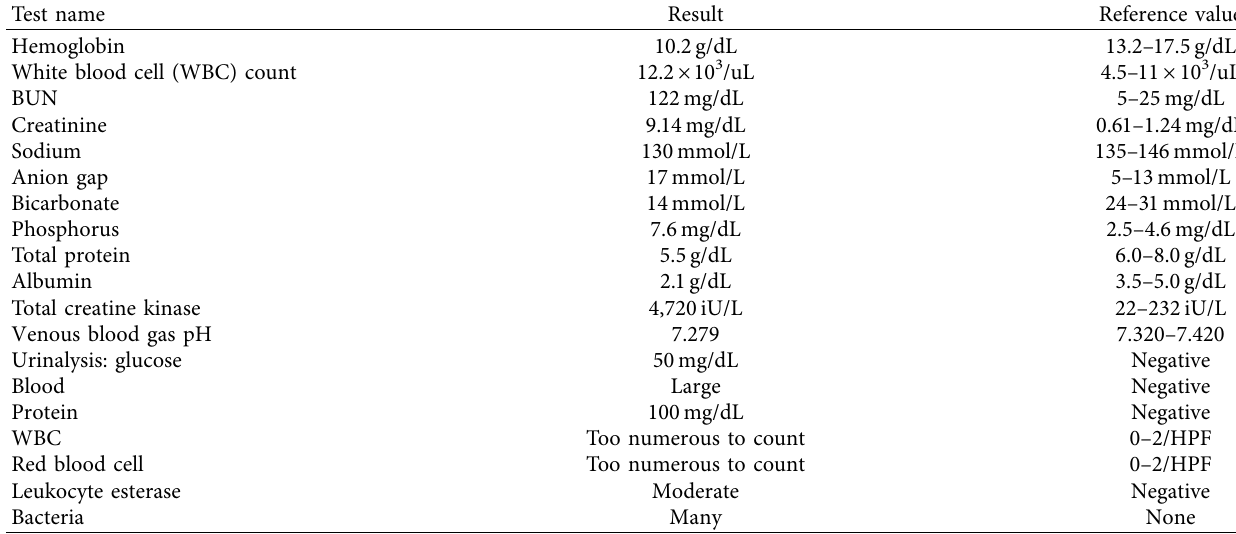
Table 1: Initial laboratory results.